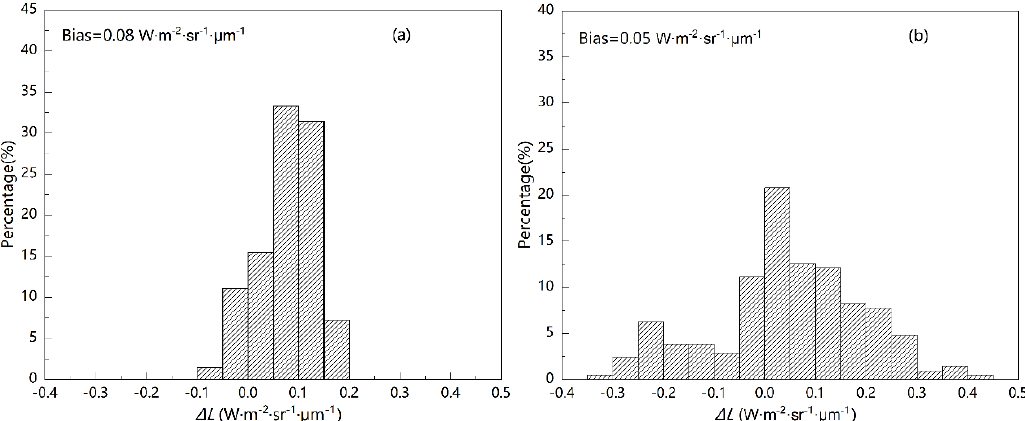
Figure 1. Histograms of the band top of the atmosphere (TOA) radiance change after the stray light correction for Landsat 8 thermal infrared sensor (TIRS) of ( a ) Band 10 and ( b ) Band 11. Δ L is the difference between TOA radiance after and before the stray light correction (after minus before).